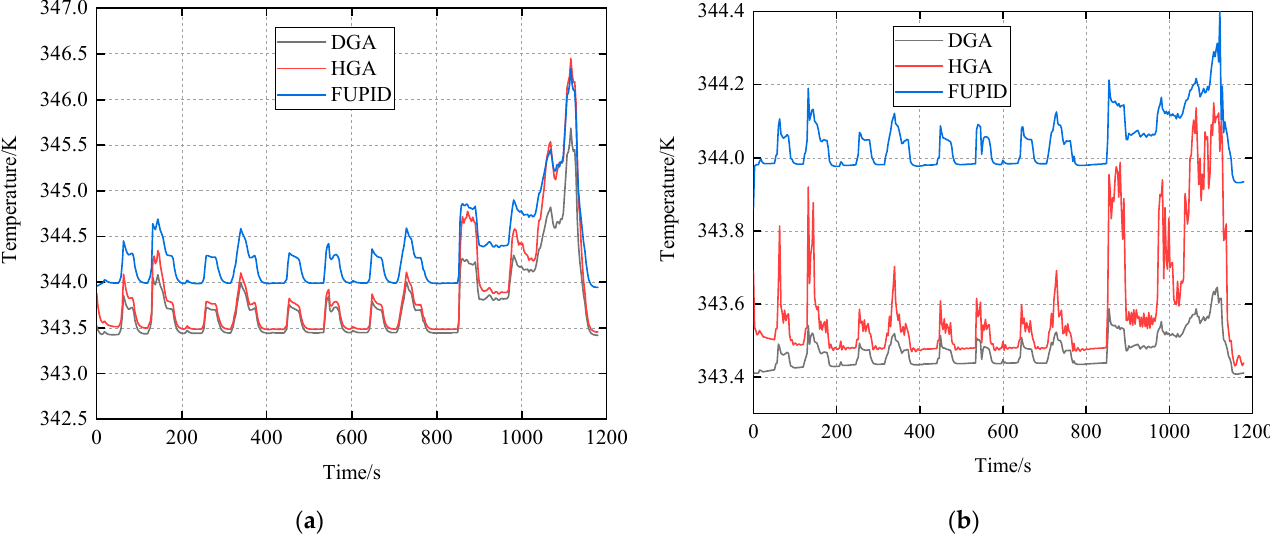
Figure 14. Diagram of temperature variation at inlet and outlet of reactor.